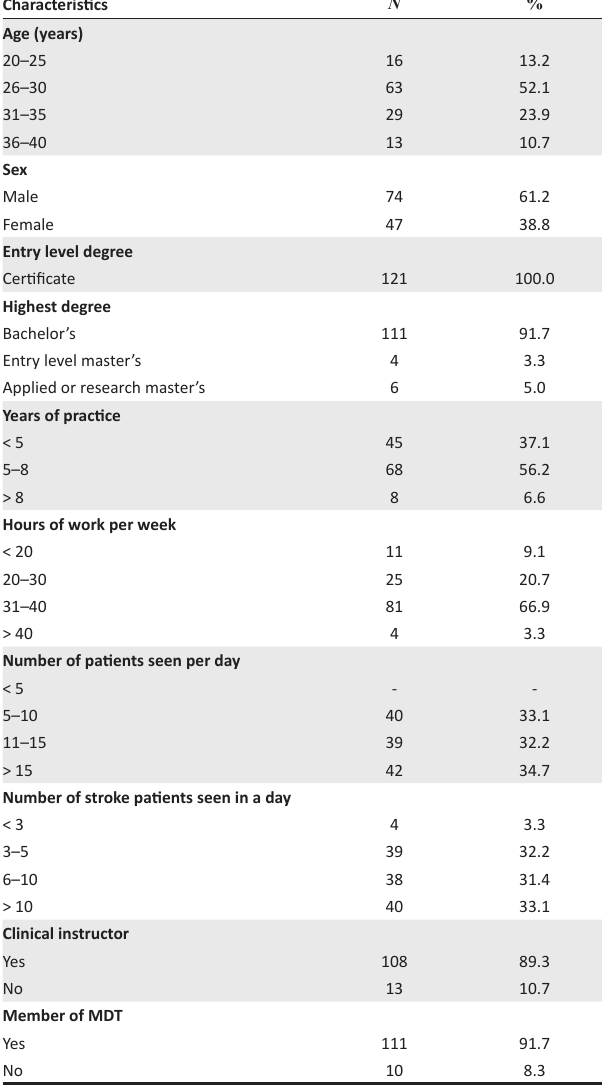
TABLE 1: Characteristics of participants and their practice ( N =